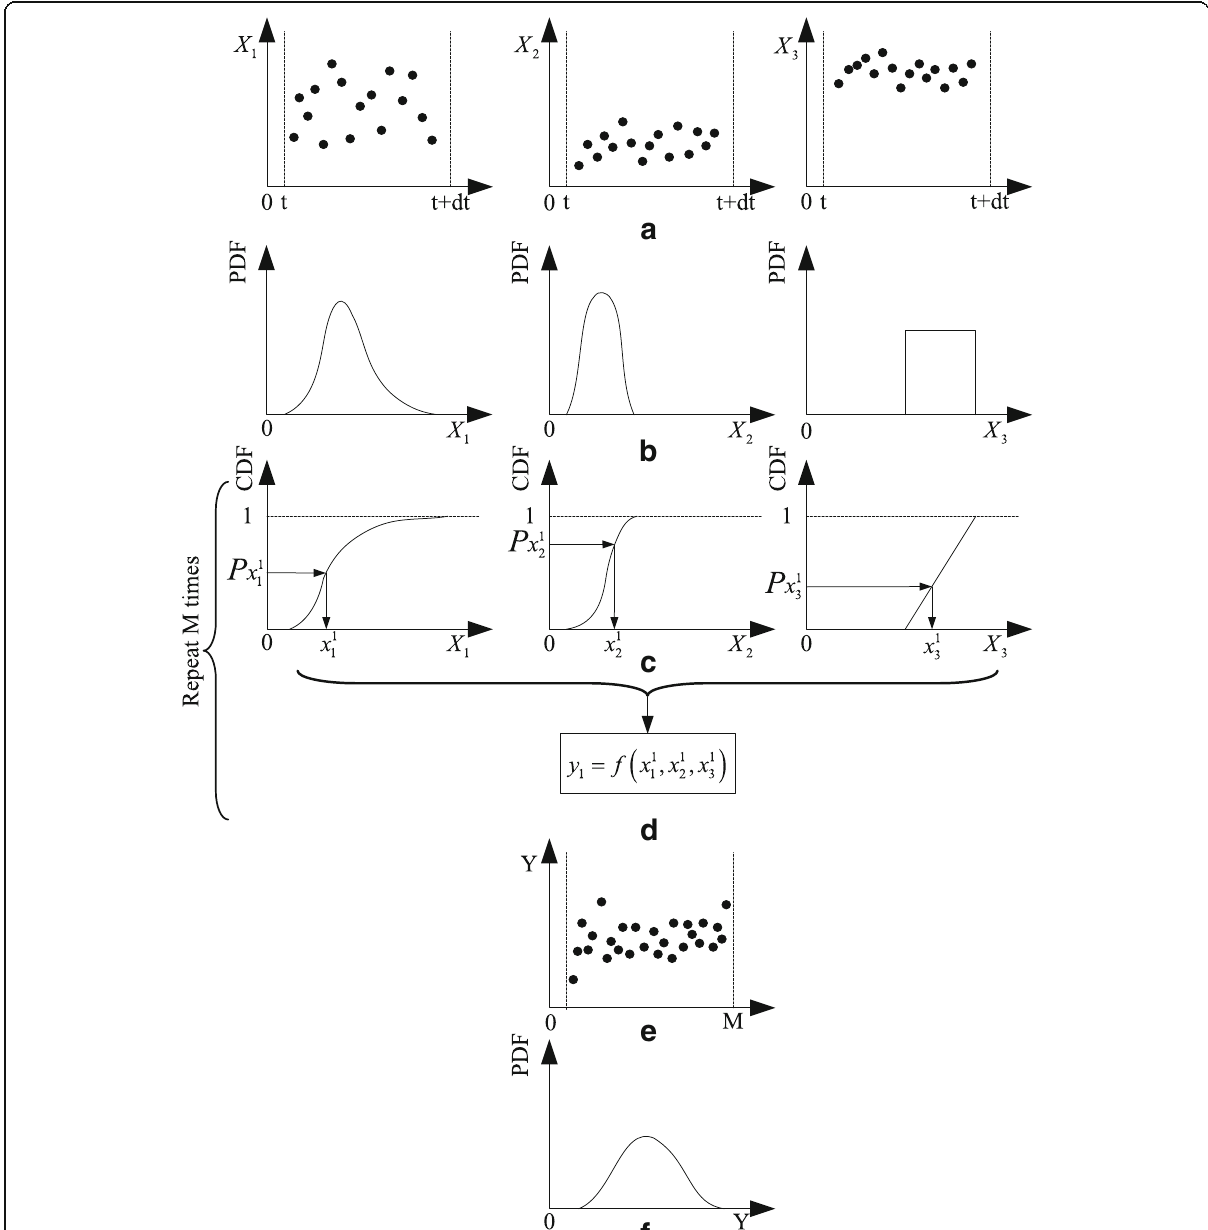
Fig. 1 Probability distribution transmission of input quantity: a input variables X 1 , X 2 , and X 3 . b PDF of X 1 , X 2 , and X 3 . c CDF of X 1 , X 2 , and X 3 . d Mathematical model between input and output. e Discrete output variable Y . f PDF of output variable